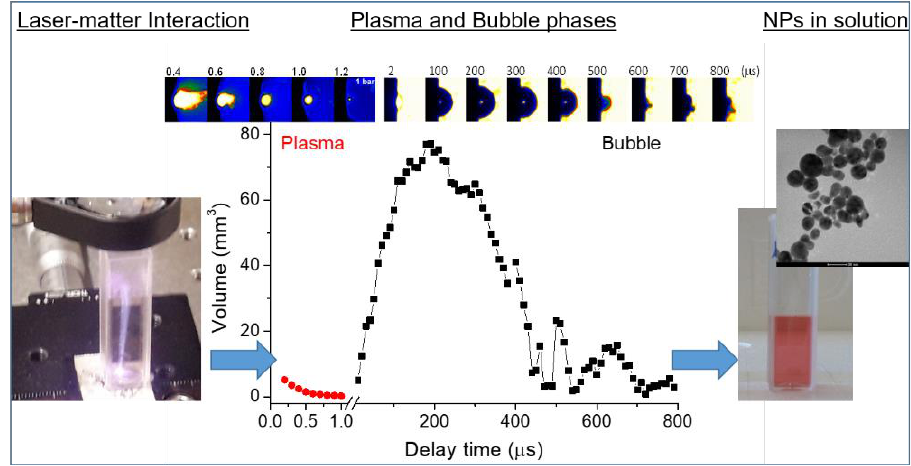
Figure 2. Different steps of Laser Ablation in Liquid (LAL). The picture of laser-matter interaction refers to a ns-laser focused on Pt target in water. The plasma and bubble images and volumes as functions of the delay time since the laser pulse have been acquired with optical emission imaging and shadowgraphy, respectively (Al target in MilliQ water, E laser = 270 mJ, laser crater size = 1.6 ± 0.2 mm, λ laser = 532 nm, laser pulse duration = 6 ns, laser frequency = 10 Hz). The nanoparticles (NPs) visible in cuvette and micrograph image are Au NPs.